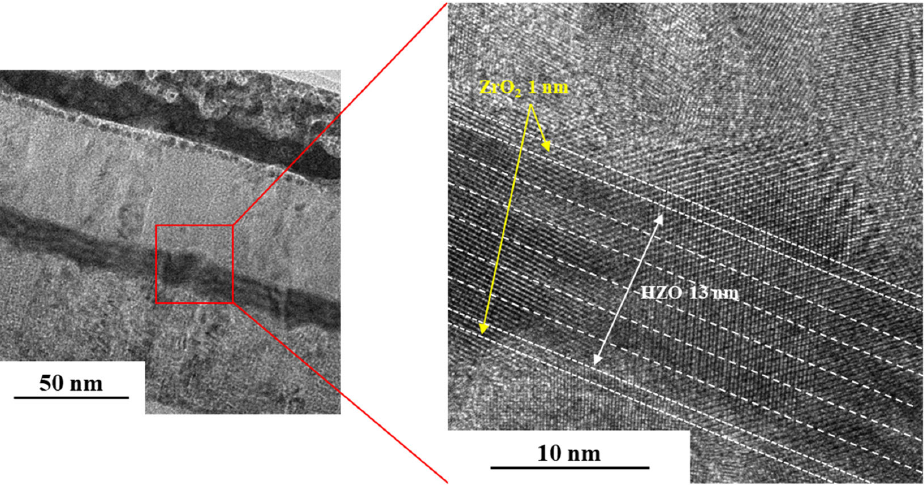
Figure 5. Cross-sectional TEM image of the D(20,20)*3 specimen annealed at 550 ◦ C. Figure 5. Cross ‐ sectional TEM image of the D(20,20)*3 specimen annealed at 550 °C. The (20,20)*3 HZO thin films heat treated at 550 °C were analyzed via XPS to inves ‐ tigate the component ratio of HZO thin films formed via PEALD. The XPS profiles are shown in Figure 6. The elemental ratio of Hf and Zr was 1:1.25; therefore, the composition of the thin film was determined to be Hf 0.44 Zr 0.56 O 2 .